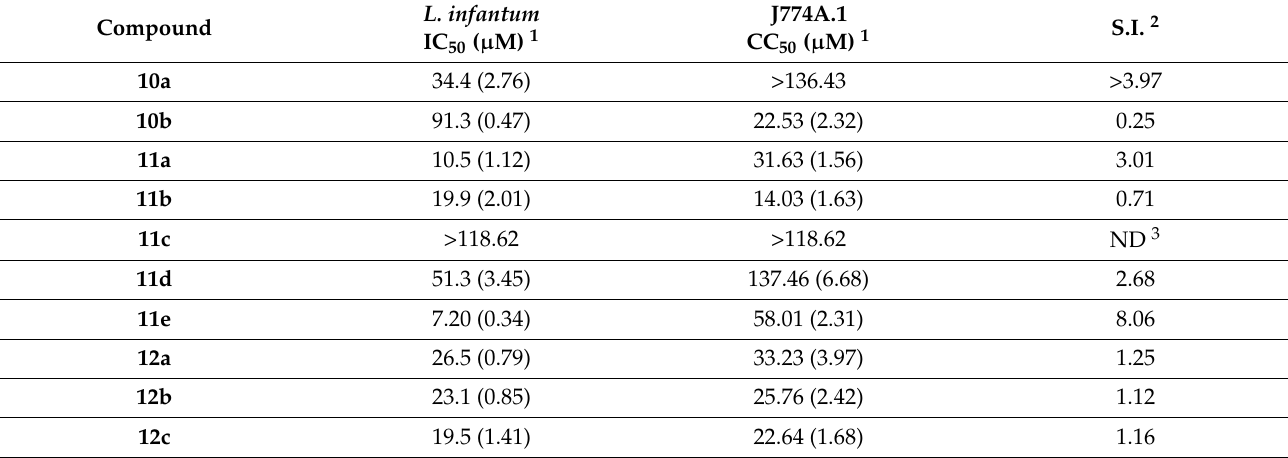
Table 2. Activity of thiochromanones against Leishmania amastigotes and evaluation of cytotoxicity.